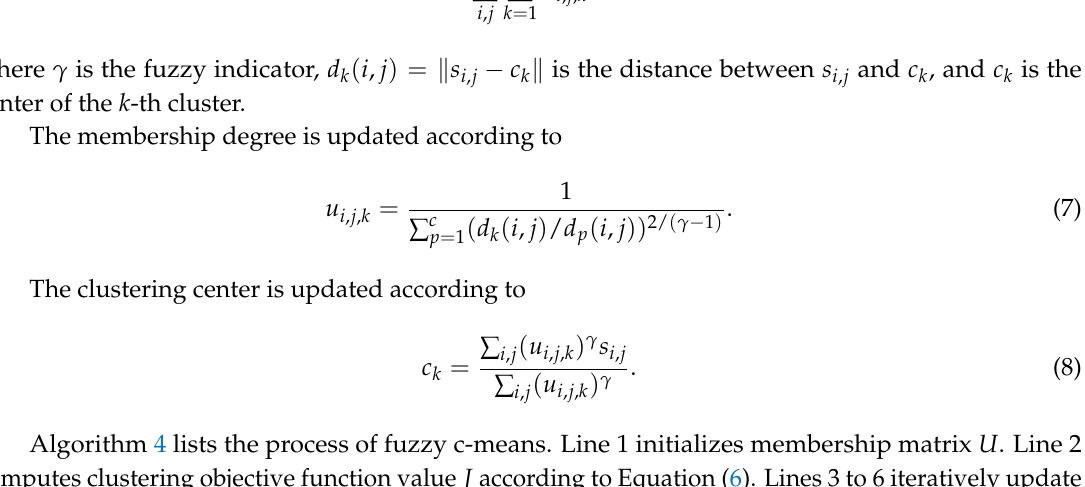
Algorithm 4 lists the process of fuzzy c-means. Line 1 initializes membership matrix U . Line